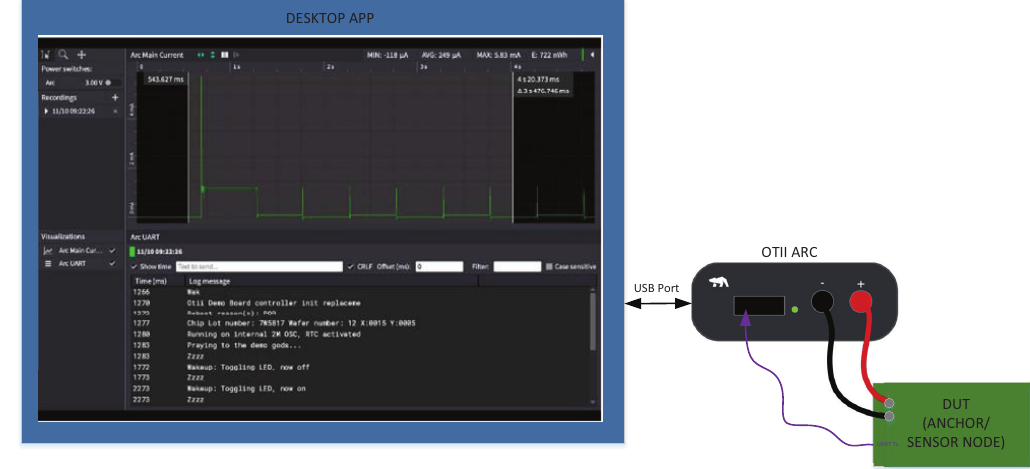
Figure 10. Implemented setup for the power consumption